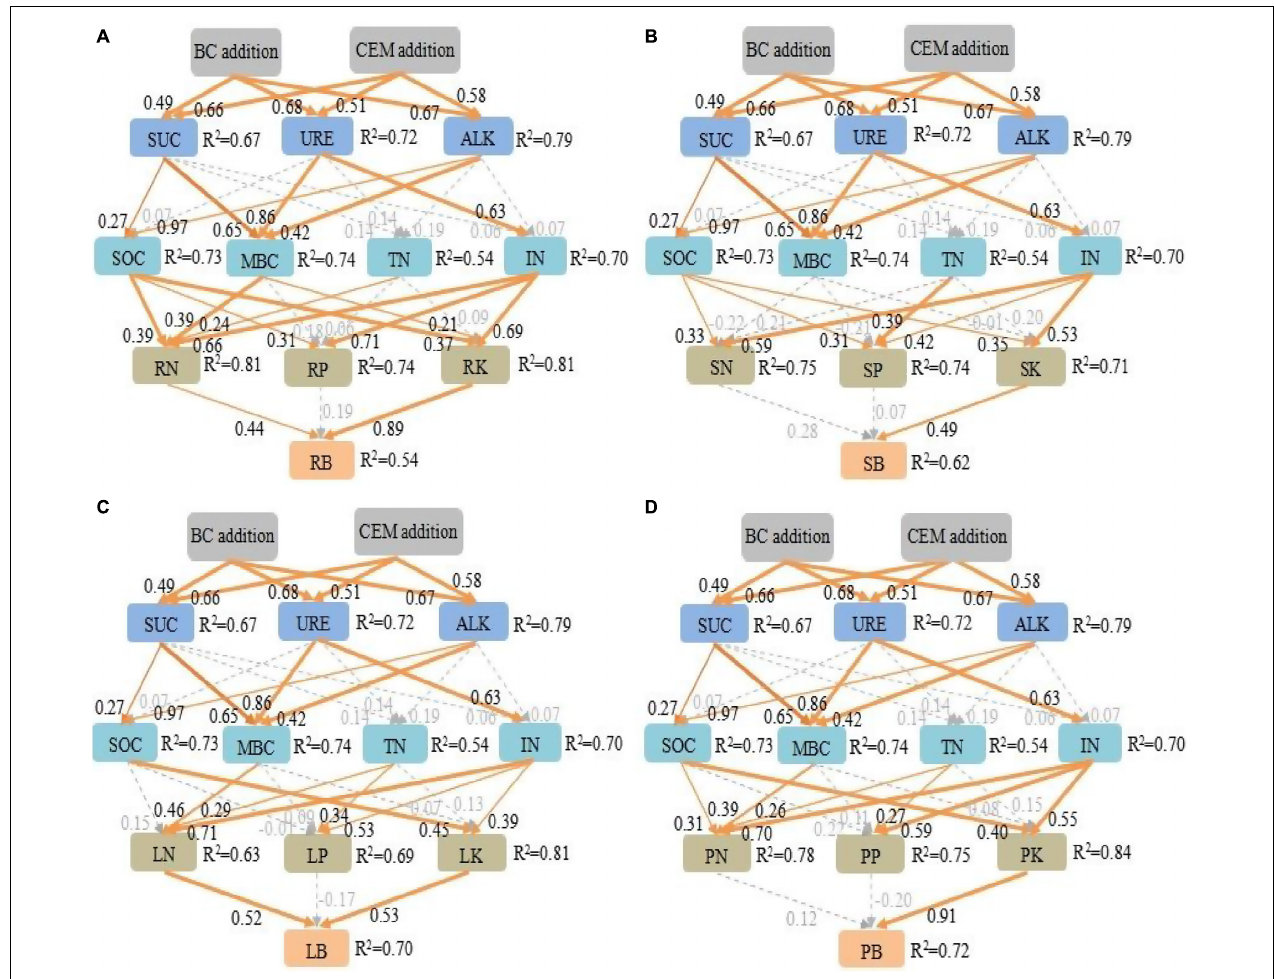
FIGURE 6 | The structure equation model investigates the plausible pathways by which biochar addition and CEM addition affected root biomass (A) , shoot biomass (B) , leaf biomass (C) , and plant total biomass (D) . Goodness-of-fit statistics for the model: root biomass: χ 2 = 118, df = 45, p < 0.05, root mean square error of approximation (RMSEA) = 0.26. Shoot biomass: χ 2 = 127, df = 45, p < 0.05, shoot mean square error of approximation (RMSEA) = 0.28. Leaf biomass: χ 2 = 113.6, df = 45, p < 0.05, leaf mean square error of approximation (RMSEA) = 0.25. Plant total biomass: χ 2 = 153.9, df = 45, p < 0.05, total mean square error of approximation (RMSEA) = 0.32. Orange solid arrows from thick to thin indicate positive pathways ( p < 0.001, p < 0.01, and p < 0.05) and light dashed gray arrows indicate non-significant relationships ( p > 0.05). The numbers next to arrows are standardized path coefficients, and the arrow width represents the strength of the relationship. The proportion of the variation ( R 2 ) values occurs aside each response variable in the model. SUC, sucrase activity; URE, urease activity; ALK, alkaline phosphatase activity; SOC, soil organic carbon; MBC, microbial biomass carbon; TN, total nitrogen; IN, NH 4 + and NO 3 − ; RN, root total nitrogen; RP, root total phosphorus; RK, root total potassium; SN, shoot total nitrogen; SP, shoot total phosphorus; SK, shoot total potassium; LN, leaf total nitrogen; LP, leaf total phosphorus; LK, leaf total potassium; PN, plant total nitrogen; PP, plant total phosphorus; PK, plant total potassium; RB, root biomass; SB, shoot biomass; LB, leaf biomass; PB, plant total